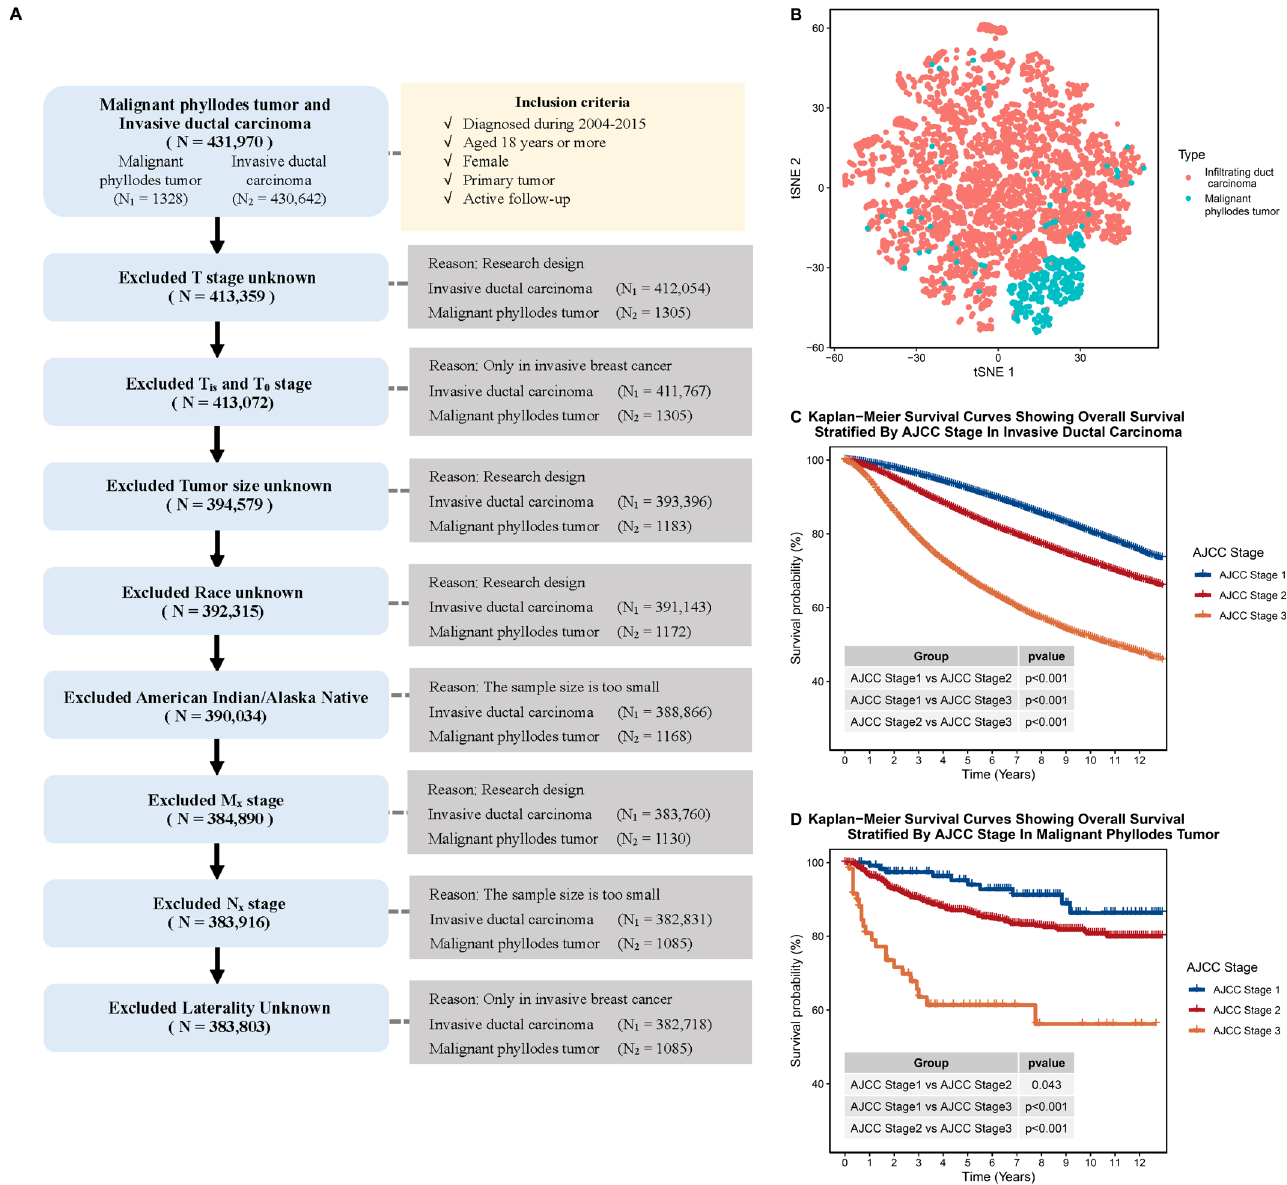
Figure 1. Comparison of clinical characteristics of patients with MPTB and patients with IDC. ( A ) Flow chart of patient selection process in our study. ( B ) The t-SNE plot showing the overall clinical characteristics of patients with MPTB and IDC (based on a sample of 10,000 randomly selected patients). ( C ) Kaplan–Meier plot showing overall survival stratified by AJCC stage in IDC. ( D ) Kaplan–Meier plot showing overall survival stratified by AJCC stage in MPTB.